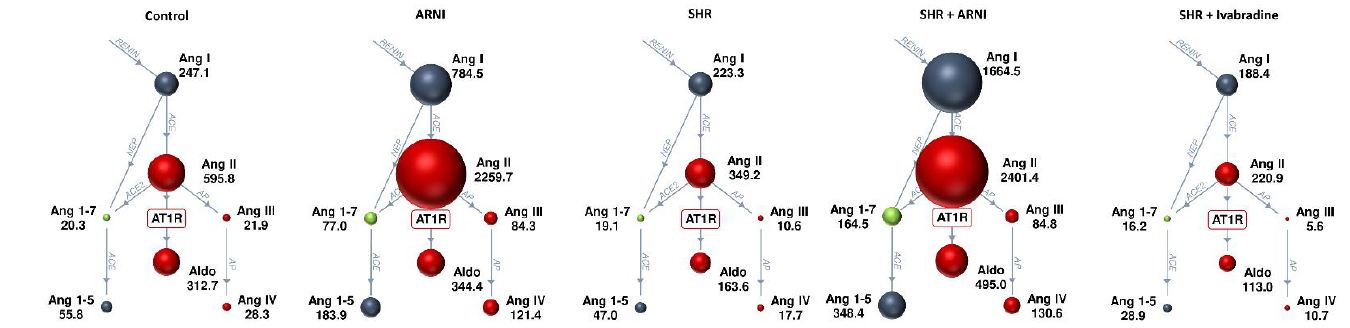
Figure 3. Schematic depicting the serum angiotensin and aldosterone concentrations in the study groups after six weeks of treatment. Results are presented as means. ACE, angiotensin-converting enzyme; Aldo, aldosterone; Ang, angiotensin; AP, aminopeptidase; ARNI, sacubitril/valsartan; AT1R, angiotensin II type 1 receptor; NEP, neprilysin (neutral endopeptidase); SHRs, spontaneously hypertensive rats. n = 6 per group.